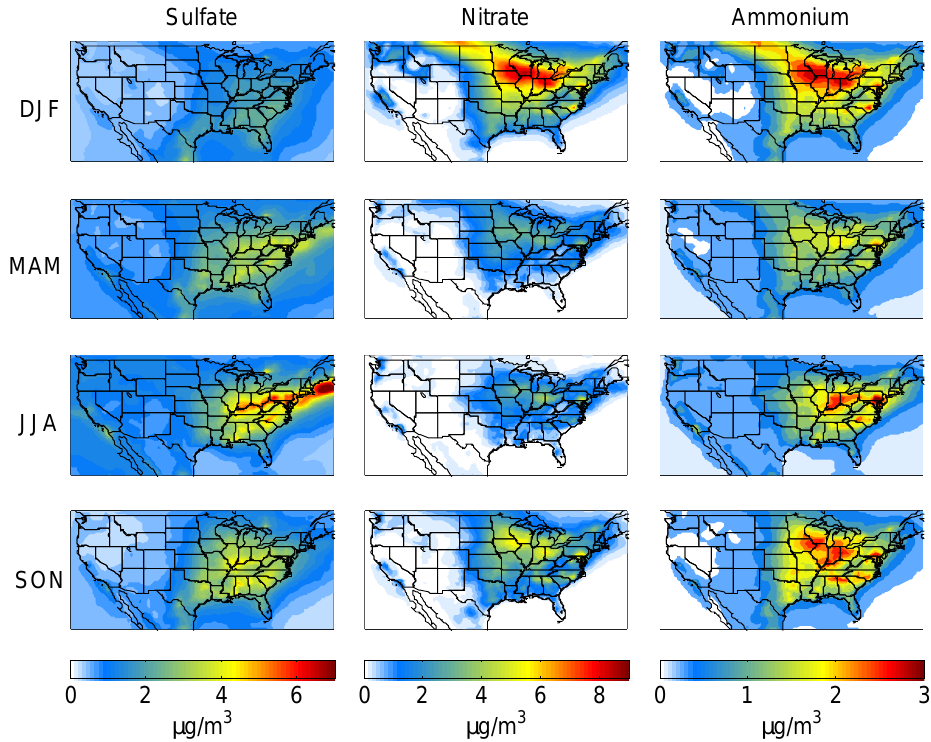
Fig. 3. Predicted concentrations of sulfate, nitrate, and ammonium aerosol for December-January-February (DJF), March-April-May (MAM), June-July-August (JJA) and September-October-November (SON),